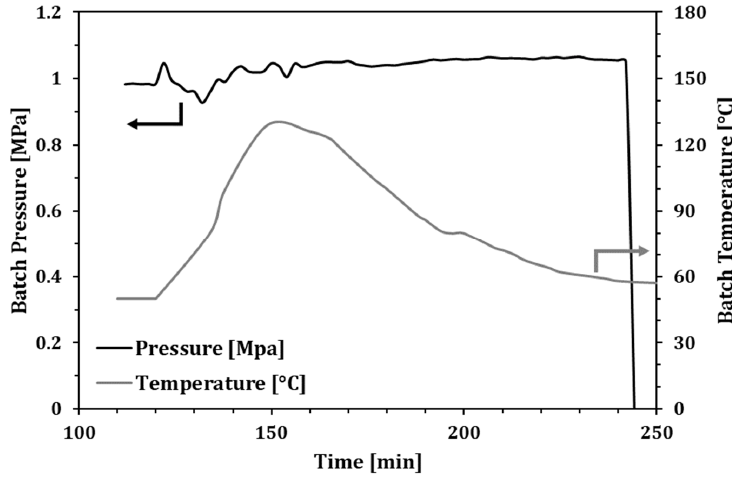
Figure 2. Batch pressure and temperature along Exp. 2.